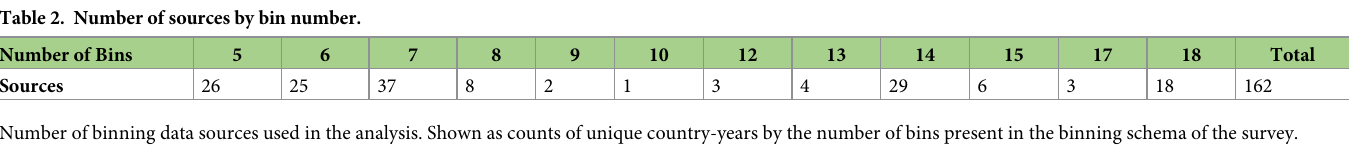
represents the logit transformed proportion of individuals in bin b who are assigned to p b , y the single-year of education y . / represent random intercepts for each country, which are l nested within / random intercepts for each region used in the Global Burden of Disease 2013 r Study[21]. / are random five-year age-group-specific intercepts, nested within / sex-specific a s random intercepts. β is a global intercept, and β captures any overall secular trend. 0 1 Space-time distance model. The second model tests the hypothesis that geography and time are the most important determinants of the proportions within each bin, and that given the large amount of data available for use in this analysis, a more accurate prediction may be achieved by strategically subsetting the training dataset to only the most proximate data. The model first determines the distance between the survey being split, and all available datasets in the training set, using a metric of space-time distance on a 0 to 1 scale. Distance in time is defined as the difference in years between the two datasets, divided by the total range of years present in the training dataset. Distance in space is created using a set of region and super- region groupings established by the Global Burden of Disease 2013 study [21]. Data from the same country have a spatial distance of 0, data in the same region have a distance of .33, data in the same super-region have a distance of .66, and all other data have a distance of 1. The